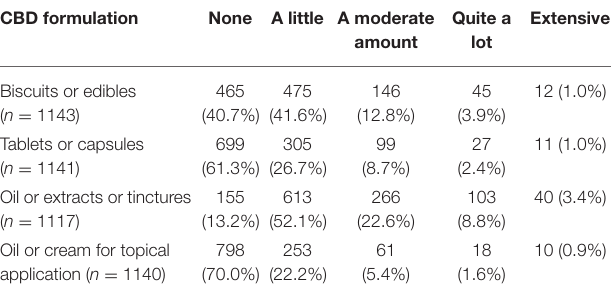
TABLE 4 | Veterinarians’ clinical experience with CBD products in dog.